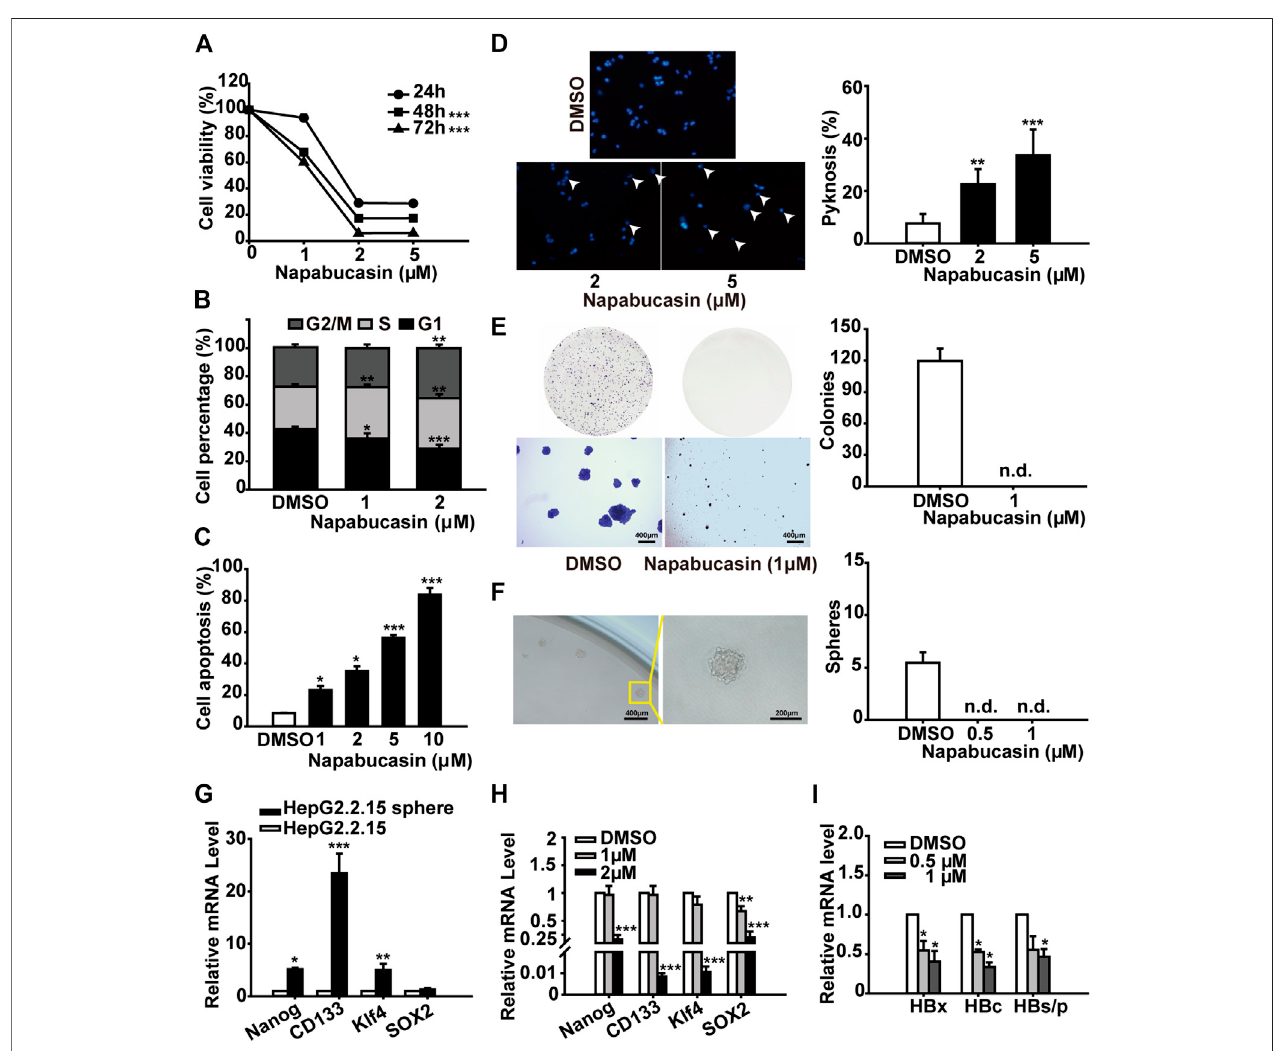
FIGURE5| NapabucasininducesapoptosisinHBV + HCCcellsanddecreasesspheroidformation. (A) ViabilityofHepG2.215cellstreatedwithDMSOorindicated concentrations of napabucasin for 24, 48 and 72 h. (B) Cell cycle distribution of HepG2.215 cells treated with DMSO or napabucasin for 24 h. (C) Percentage of apoptotic HepG2.215 cells following treatment with DMSO or napabucasin for 12 h. (D) Representative images ( × 40 magni fi cation) of Hoechst 33342-stained HepG2.215 cells treated with napabucasin for 6 h (left) and quanti fi cation of pyknosis (right) . (E) Representative images of colonies formed by DMSO or napabucasin-treated HepG2.2.15 cells (left) and quanti fi cation of colonies (right) . (F) Representative images of multicellular spheroids larger than 80 μ m (left) and quanti fi cation of spheroids derived from DMSO- or napabucasin-treated HepG2.215 cells (right) . (G) Stemness marker expression in the spheres derived